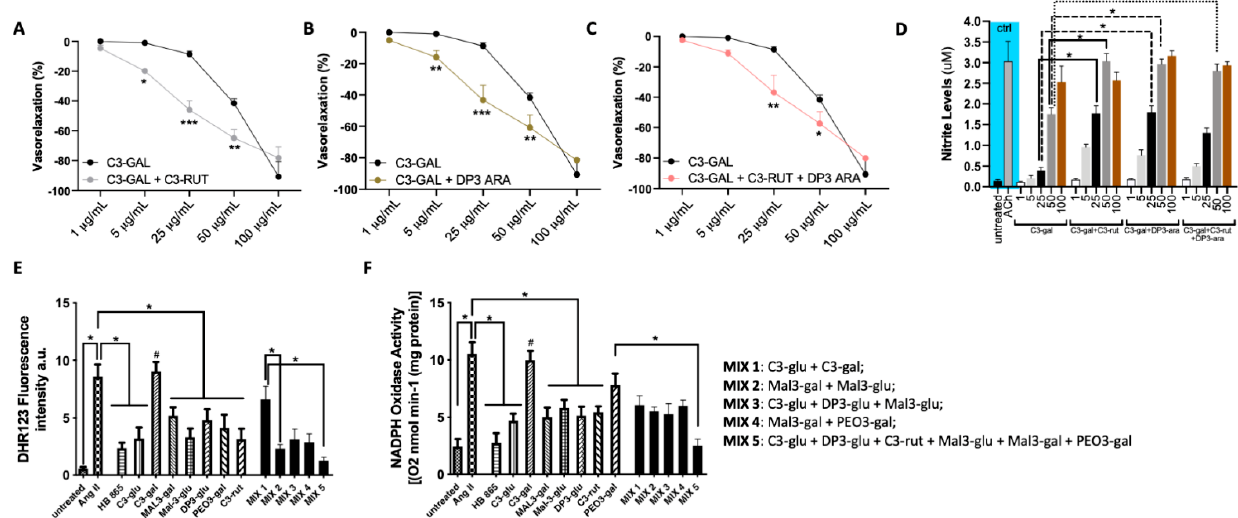
Figure 7. ( A – C ) Vascular response of phenylephrine-precontracted mice mesenteric arteries to increasing doses of a combination of anthocyanins mixed with a ratio 1:1. ( A ) cyanidin-3-galactoside (C3-gal) plus cyanidin-3-rutinoside (C3-rut); ( B ) cyanidin-3-galactoside (C3-gal) plus delphinidin-3-arabinoside (DP3-ara); ( C ) cyanidin-3-galactoside (C3-gal) plus cyanidin-3-rutinoside (C3-rut) plus delphinidin-3-arabinoside (DP3-ara); N = 3 for each curve. ( D ) Nitrite measurement in organ bath after stimulation with increasing doses of different mix ( N = 3 for each treatment). ( E , F ) Measurement of ROS production by DHR123 in vessels ( N = 4 for each treatment) treated with anthocyanins mixture and ( F ) NADPH oxidase activity ( N = 4 for each treatment). Data are expressed as increase of chemiluminescence per minute. * p < 0.05; ** p < 0.01, *** p < 0.001; # p < 0.05.